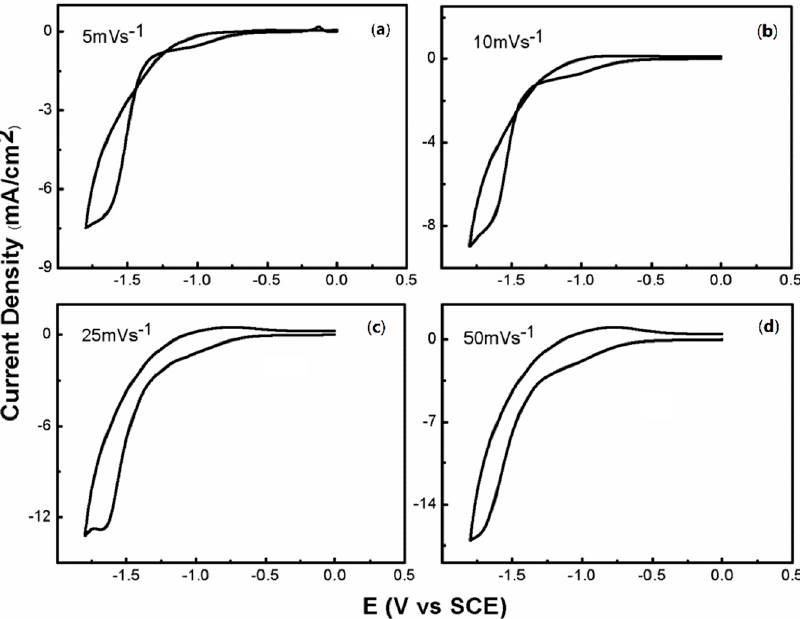
Figure 6. Effect of scan rate on the cyclic voltammograms of SLM-Ti scaffolds. ( a ) 5 mV · s − 1 , ( b ) 10 mV · s − 1 , ( c ) 25 mV · s − 1 , ( d ) 50 mV · s −